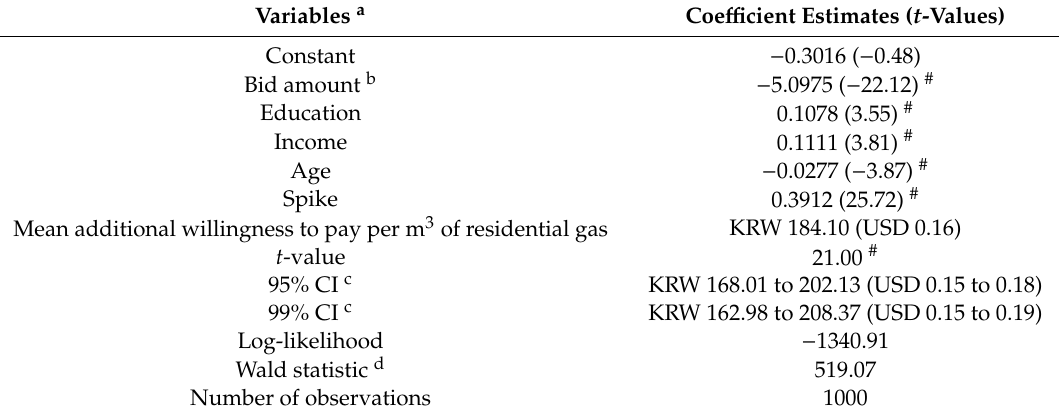
Table 5. Estimation results of the model with